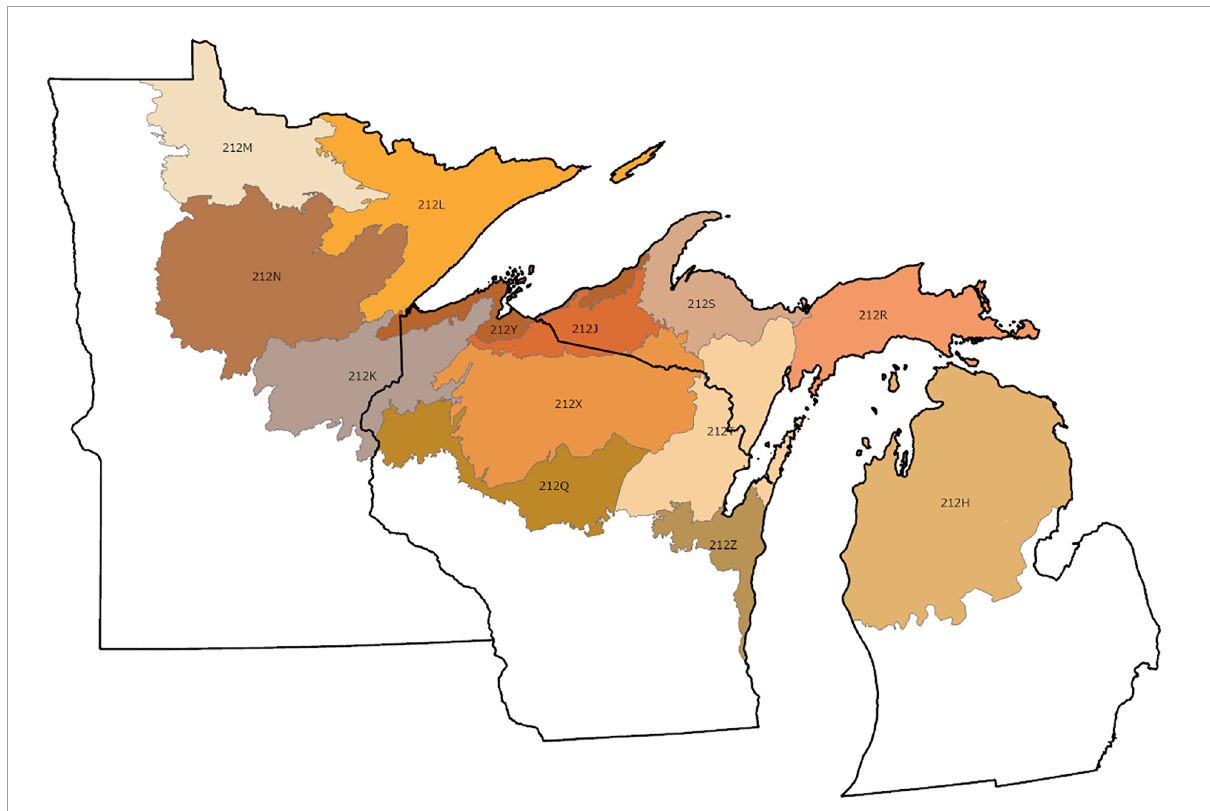
FIGURE5 Ecological sections composing the Laurentian Mixed Forest (Source: Cleland et al., 2007).